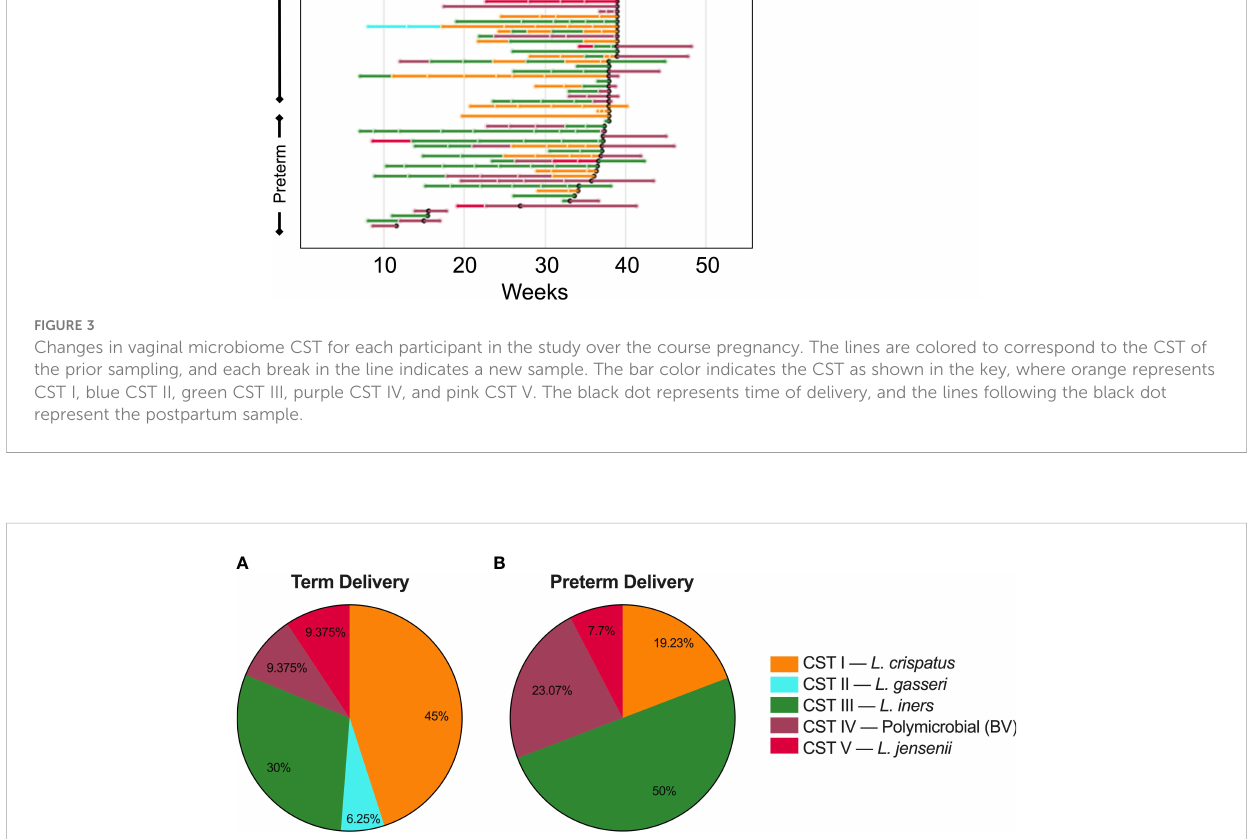
Figure 5G. CST I showed 52.6 ± 25.5% mobility. Particle mobility was the highest in CST II at 87.7 ± 8.1%. 100 nm CP were signi fi cantly less mobile in CST I samples than in CST IV samples ( p < 0.0001). As expected, particle mobility is signi fi cantly positively correlated with sample pH (Supplementary Figure 8). Furthermore,